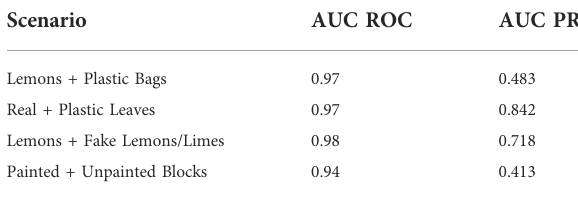
TABLE 2 Anomaly detector performance with the area under the Receiver Operator and Precision Recall